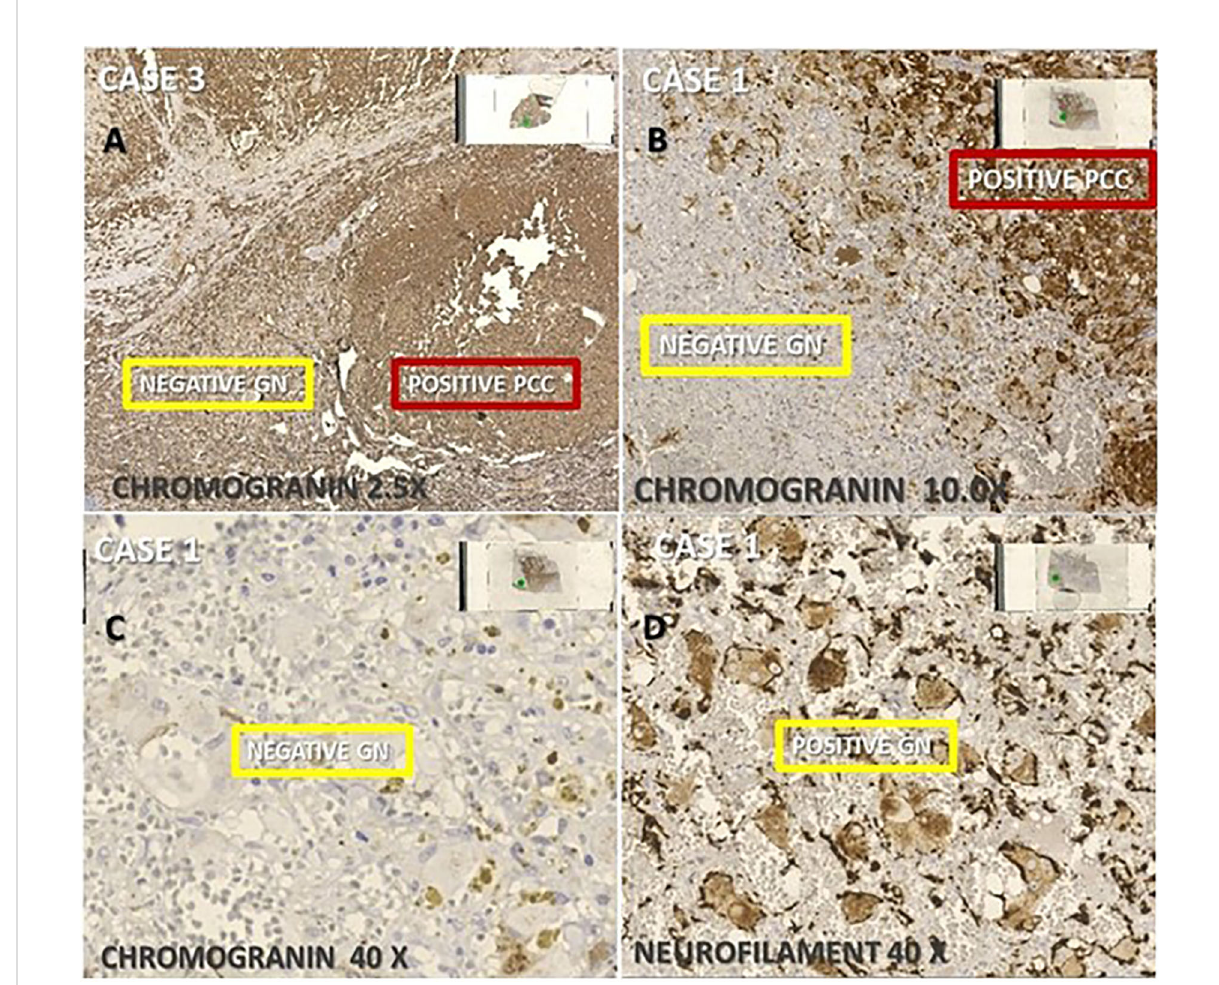
FIGURE 2 Immunohistochemistry (IHQ) of the three composite pheochromocytoma (CP) cases associated with ganglioneuroma, (A) ×2.5 and (B) ×10. IHQ was positive for chromogranin in pheochromocytoma (PCC) and negative ganglioneuroma (GN); (C) negative expression of chromogranin in GN; and (D) positive IHQ for neuro fi lament in